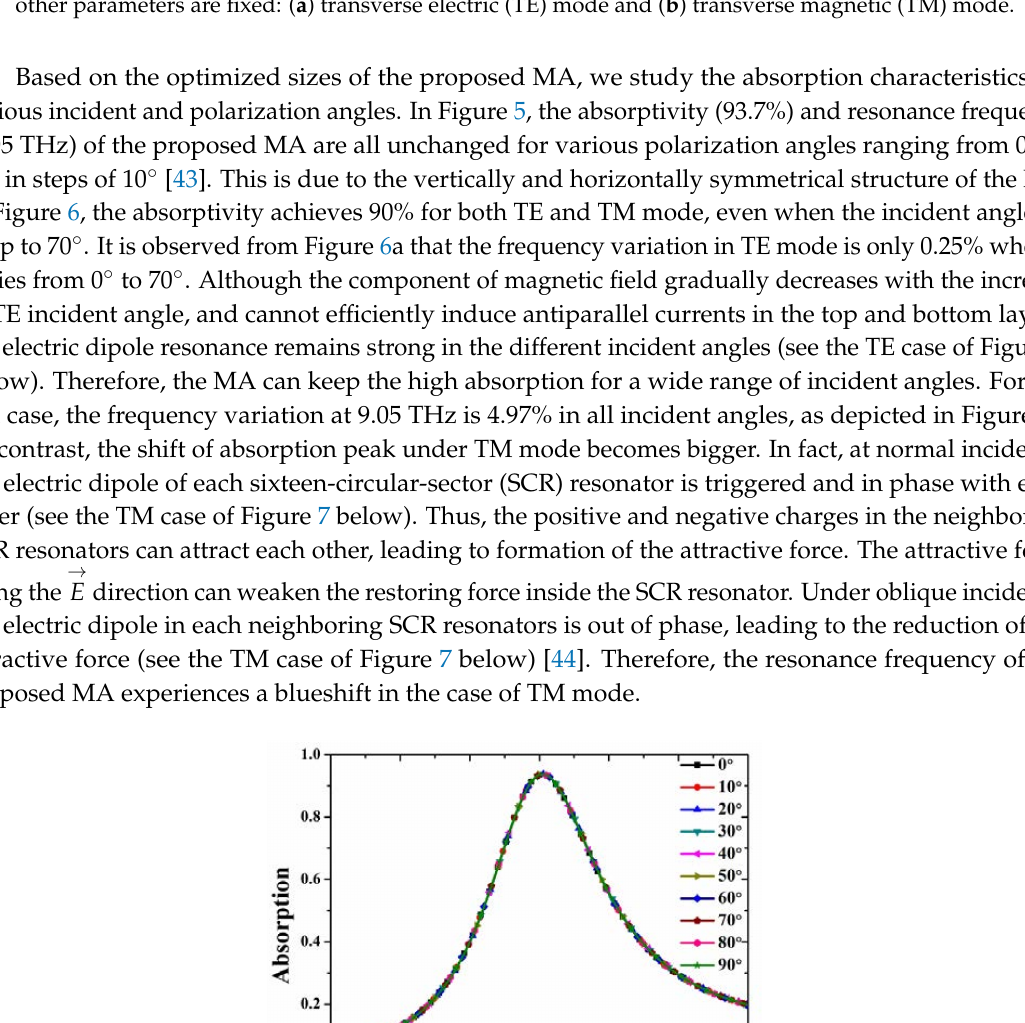
Figure 4. Absorption spectra of different dielectric thicknesses under an incident angle of 70 ◦ when the other parameters are fixed: ( a ) transverse electric (TE) mode and ( b ) transverse magnetic (TM) mode.